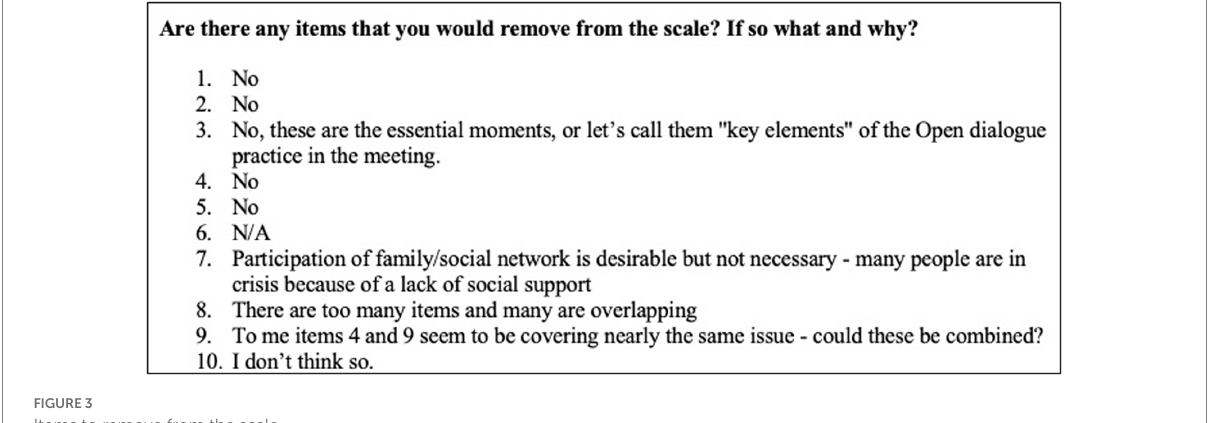
FIGURE 3 Items to remove from the scale.